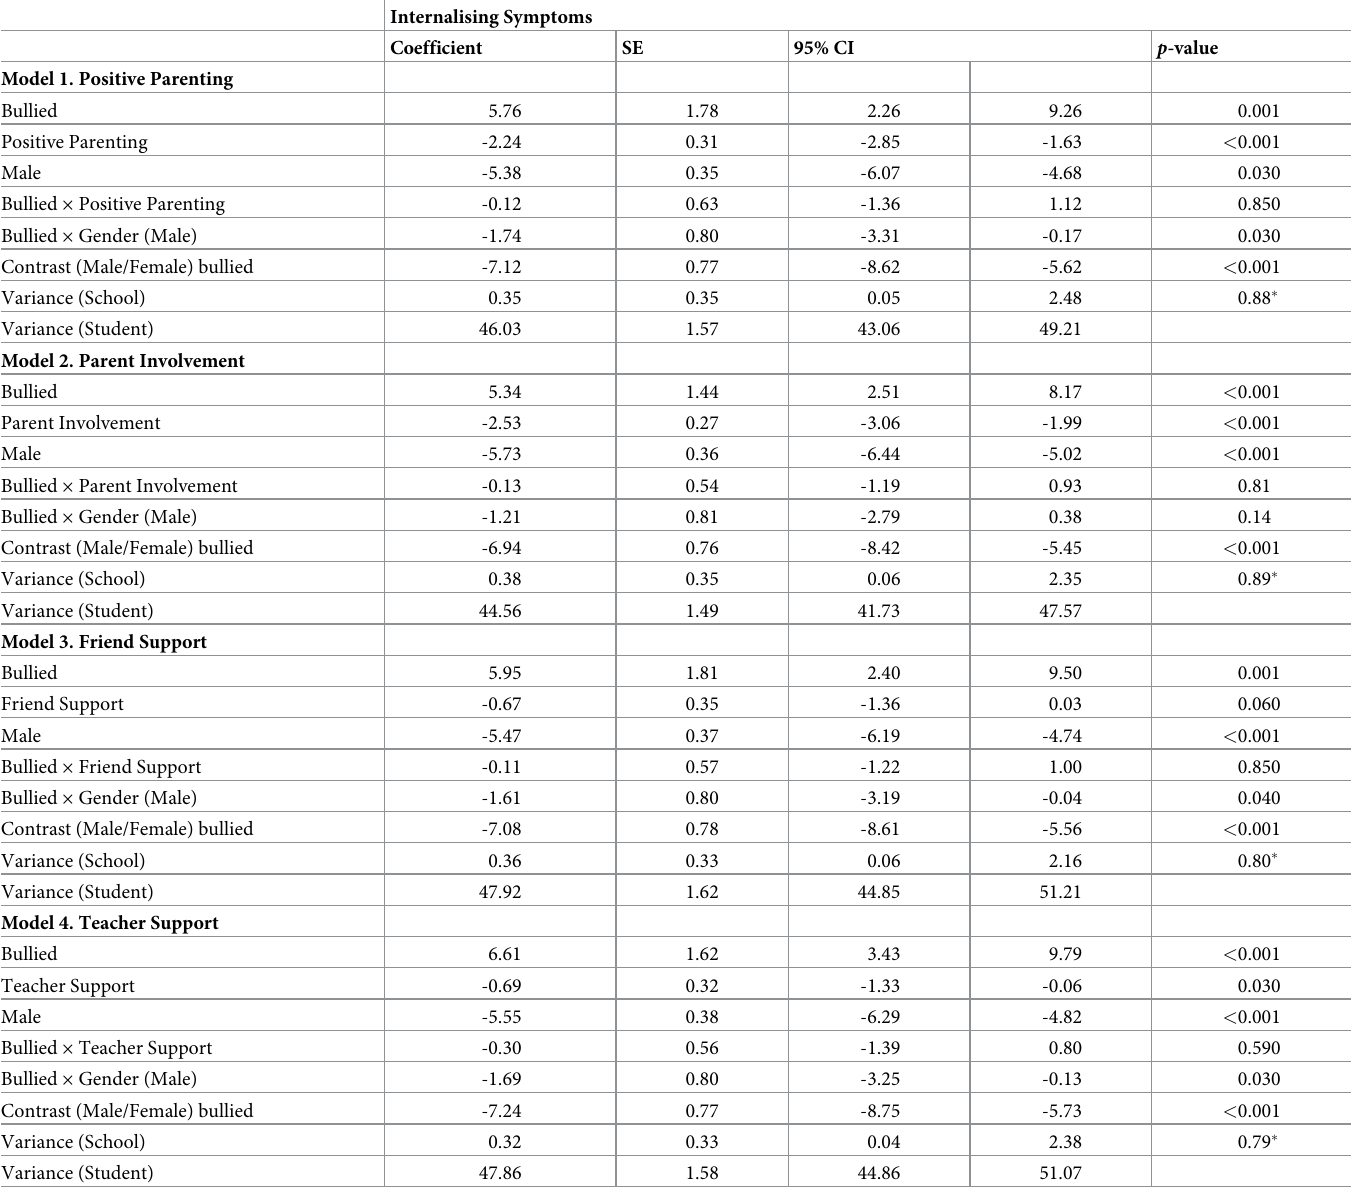
Table 4. Linear mixed-effects models of bullied once per week, type of social support & interactions (weighted). Internalising Symptoms Coefficient SE 95%